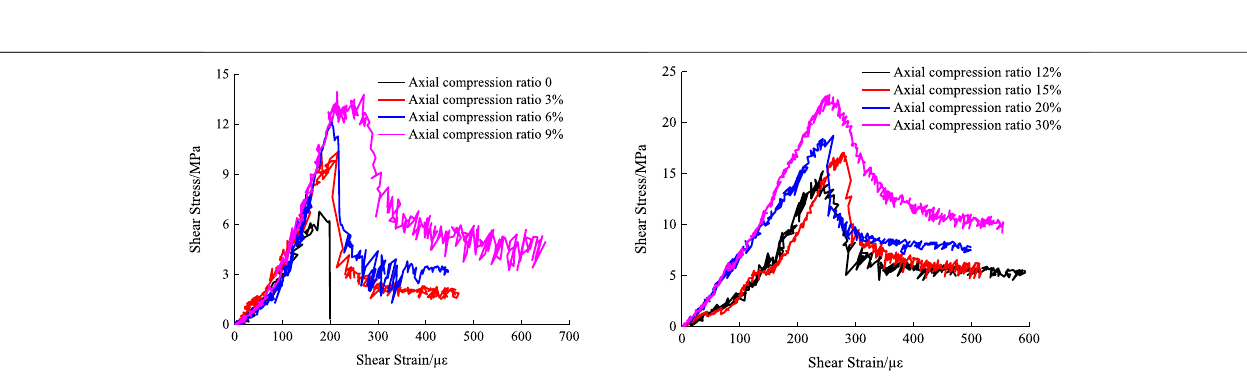
FIGURE 9 | Shear stress-strain curves of SCC under different axial compression